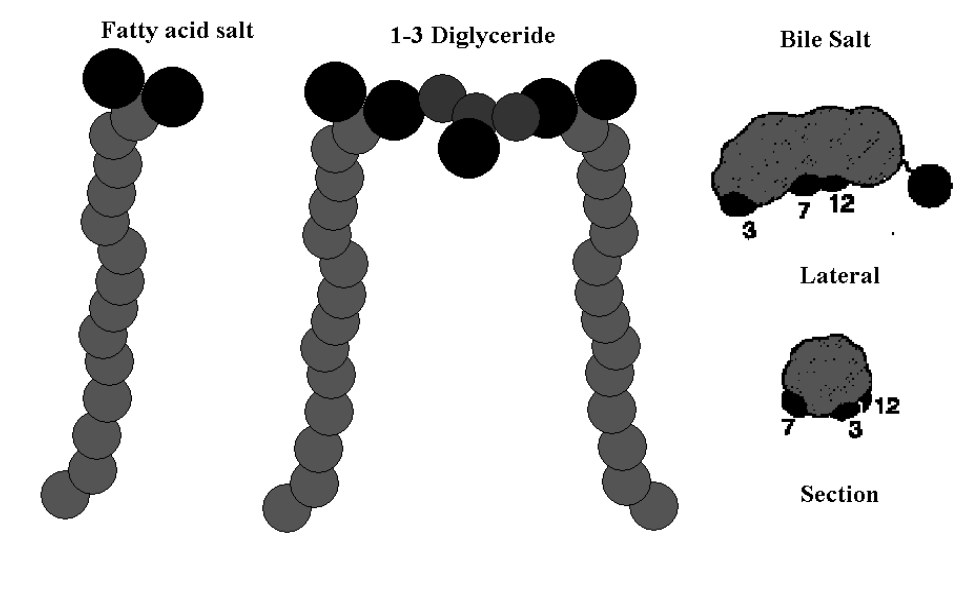
Figure 1. Comparison of the chemical structures of fatty acids salts, left, di-glycerides, in the centre, and BS , respectively. Oxygen atoms are in black, the glycerol carbons of di- glycerides in dark grey. Molecular sizes are not in